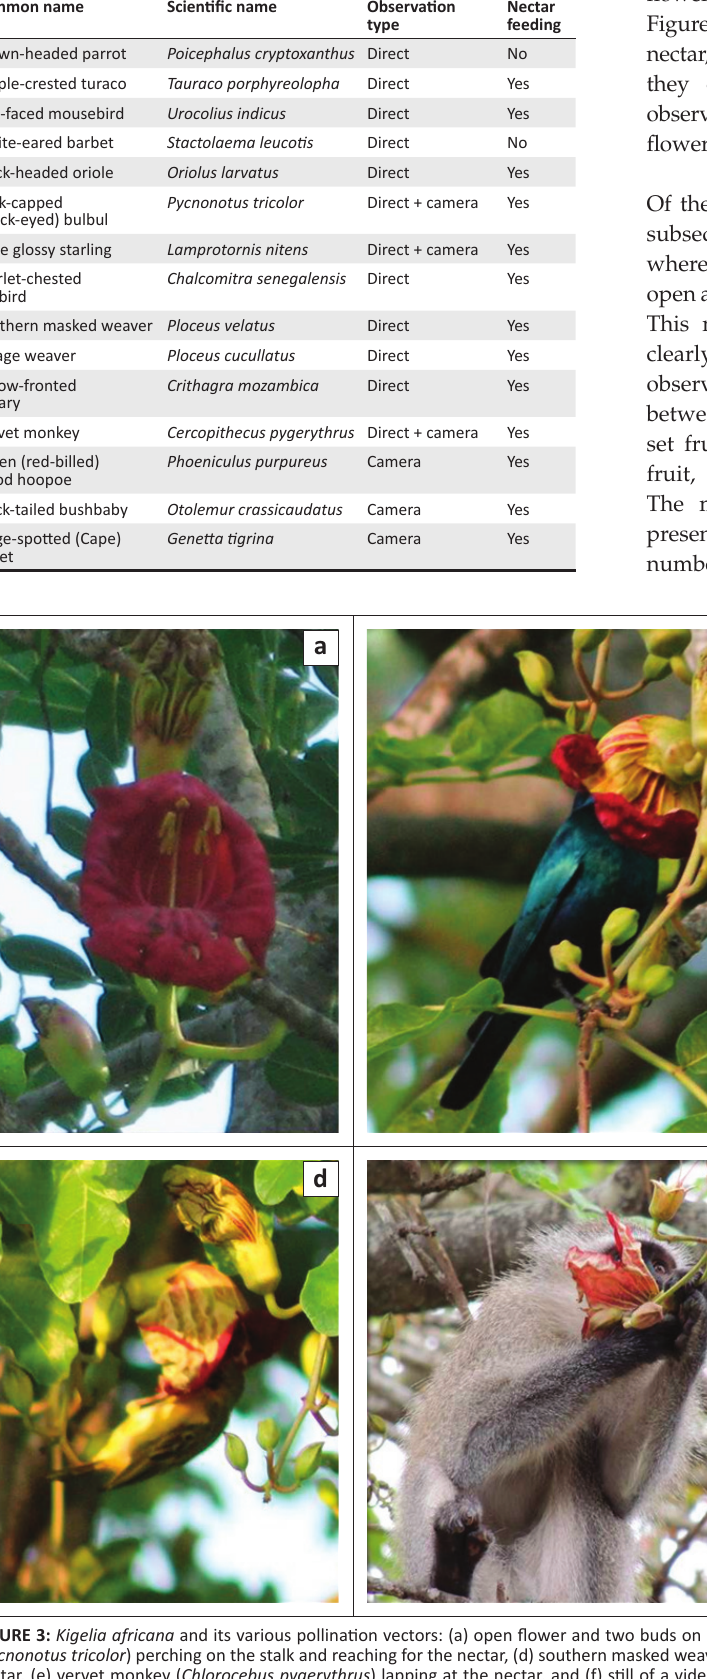
TABLE 1: Direct and camera observations of various animal species that visited the flowers of Kigelia africana . Common